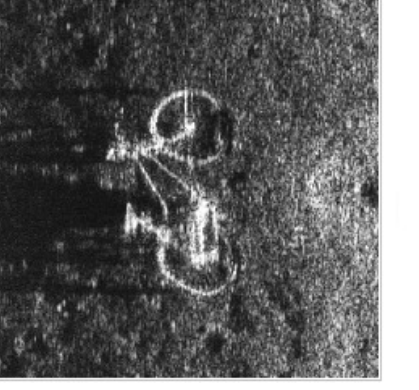
Figure 25. Results for test image